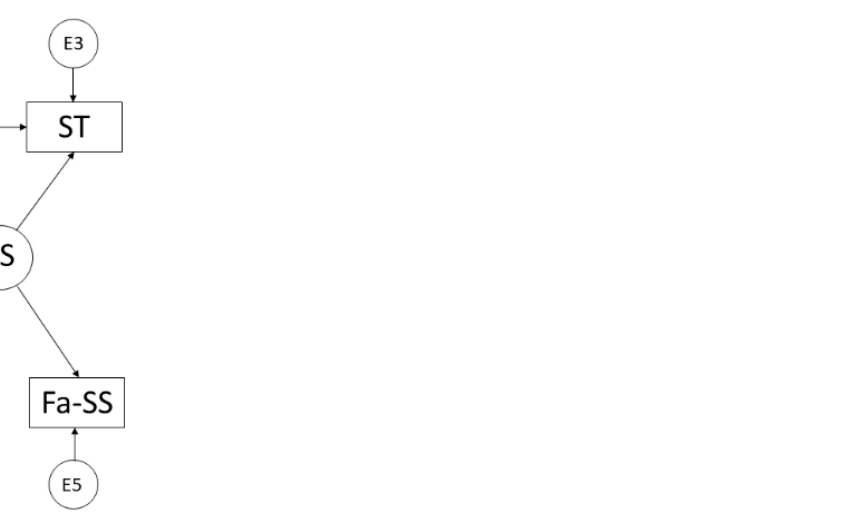
Figure 1. Proposed theoretical model. Note: Physical Activity (PA); Social Support (SS); Screen Time (ST); Family Support (Fa-SS); Friends' Support (Fr-SS).